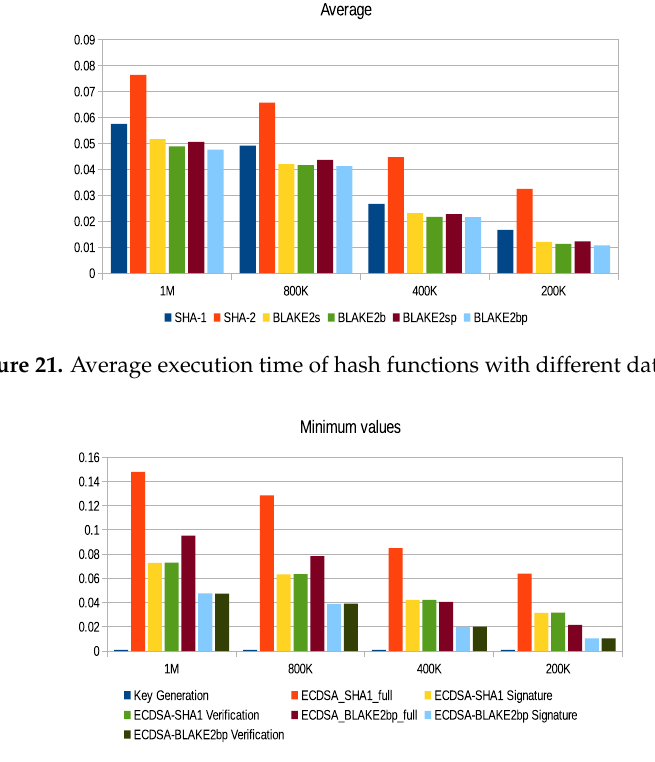
Figure 22. Minimum execution time of ECDSA algorithms with different data sizes.